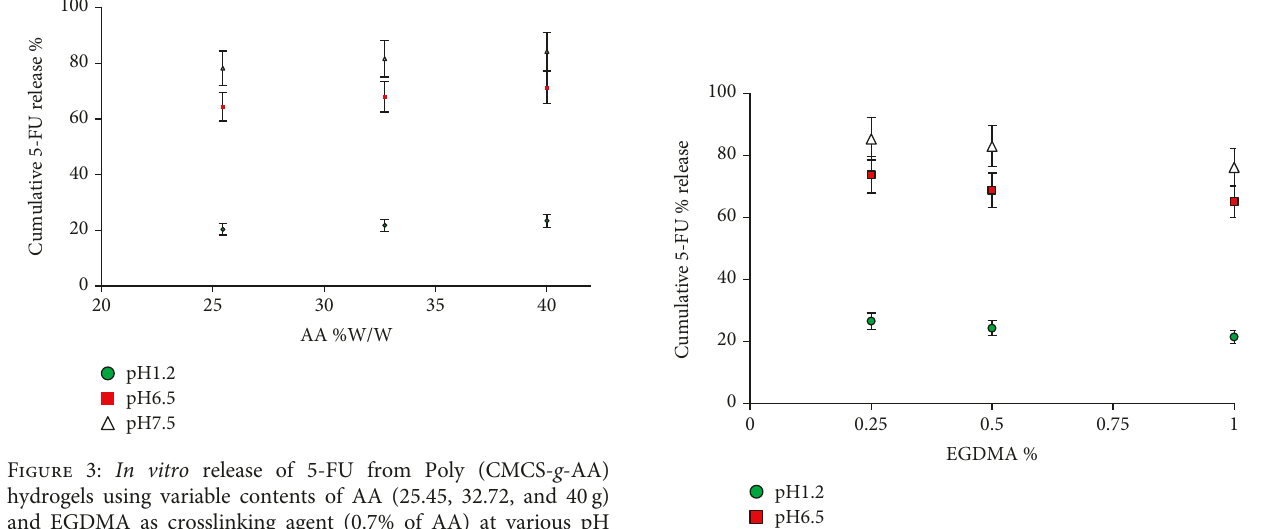
Figure 4: Dynamic swelling coe ffi cient of Poly (CMCS- g -AA) hydrogels with di ff erent concentration of CMCS (1.20 1.40, and 1.60 g) using EGDMA as the crosslinking agent (0.7%) of AA in 0.05 M USP phosphate bu ff er solutions of di ff erent pH at 37 ° C.